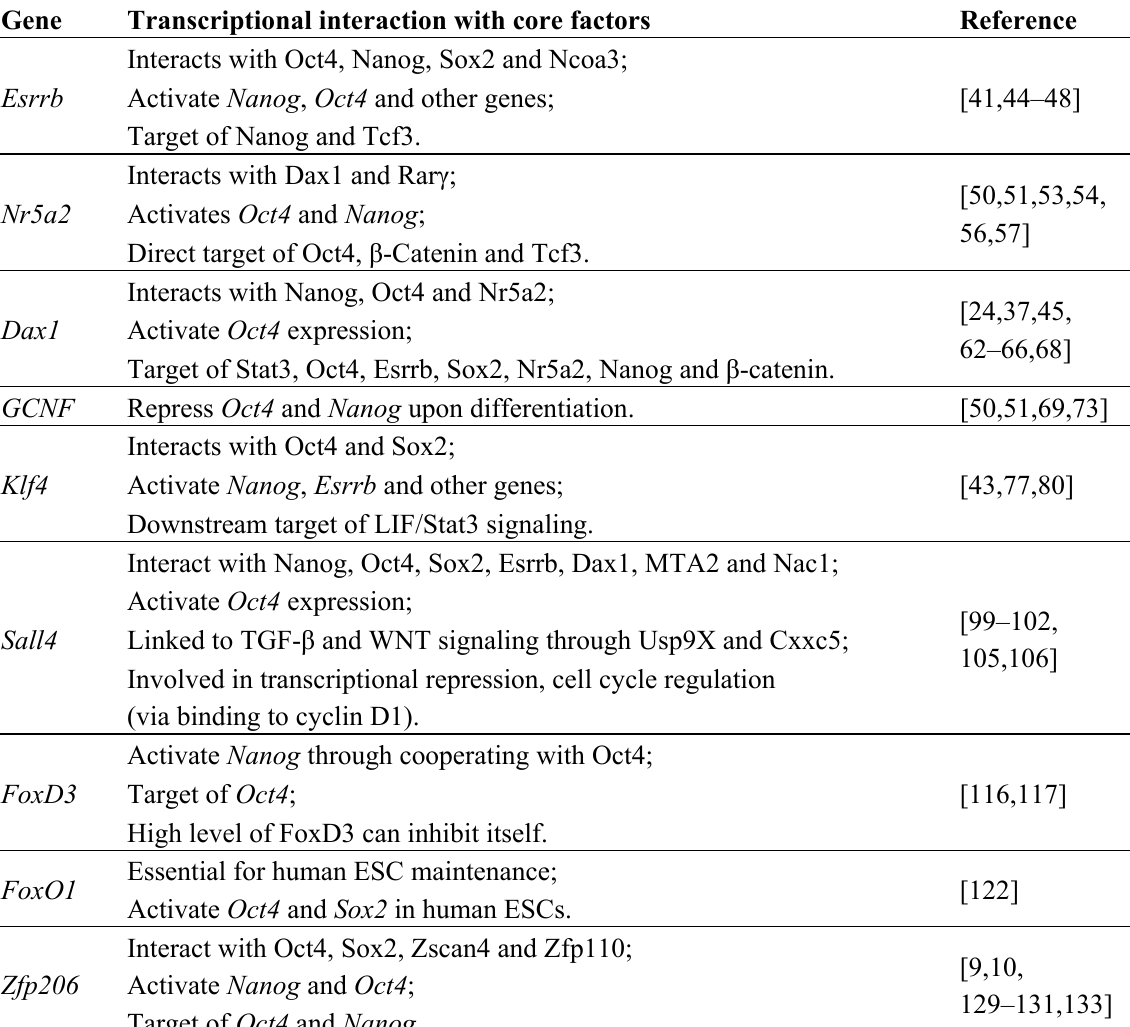
Table 1. Connections between ancillary and core pluripotency transcription factors. Gene Transcriptional interaction with core factors